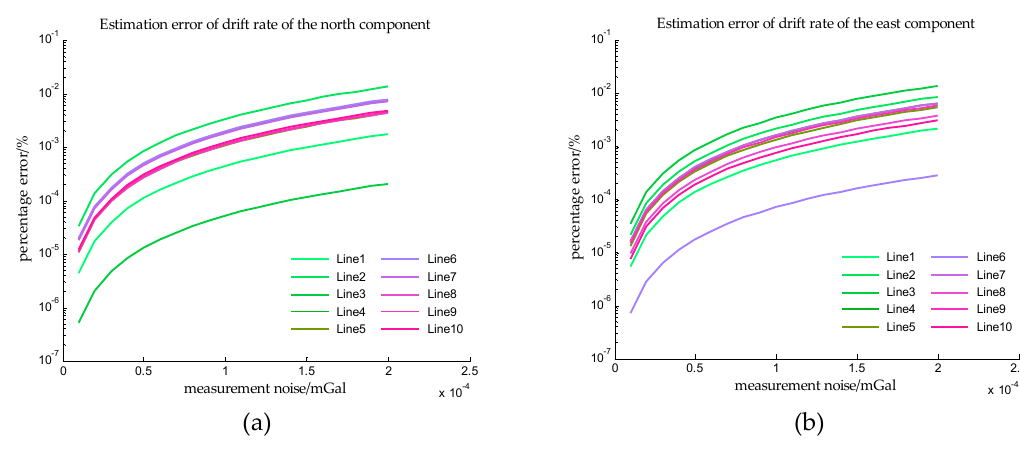
Figure 15. The estimation error of drift rate in simulation III. ( a ) is the estimation error of the drift rate of the north component, and ( b ) is the estimation error of the drift rate of the east component.